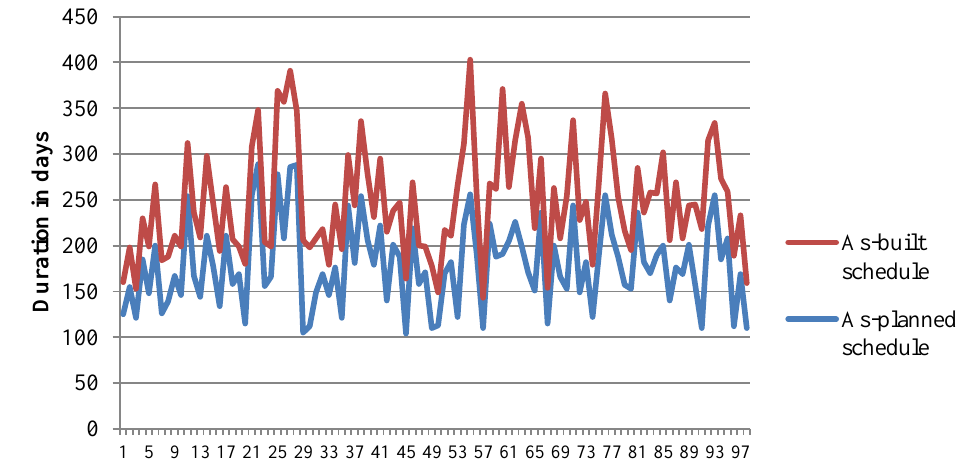
Fig. 1. Range of as-planned schedules with as-built schedules [figure made by